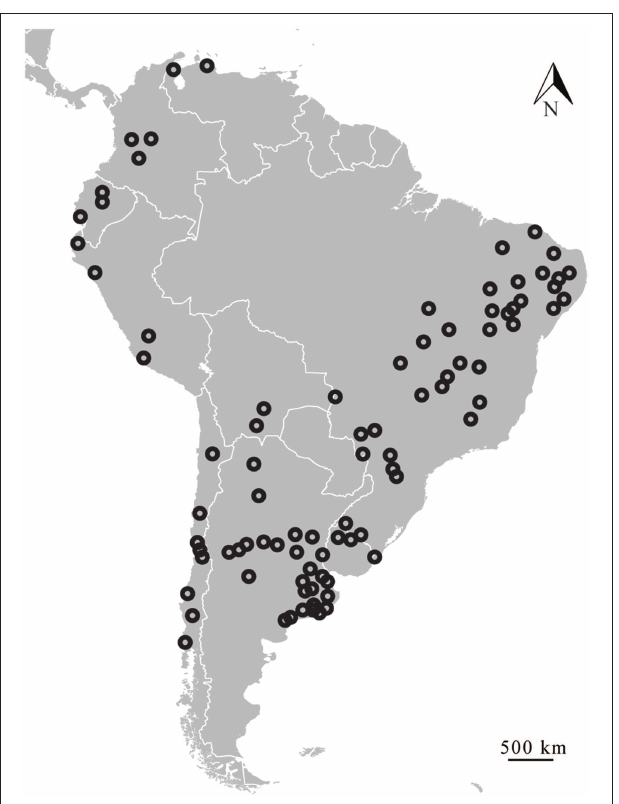
FIGURE 10 | Updated map of South American Equus fossil occurrences.